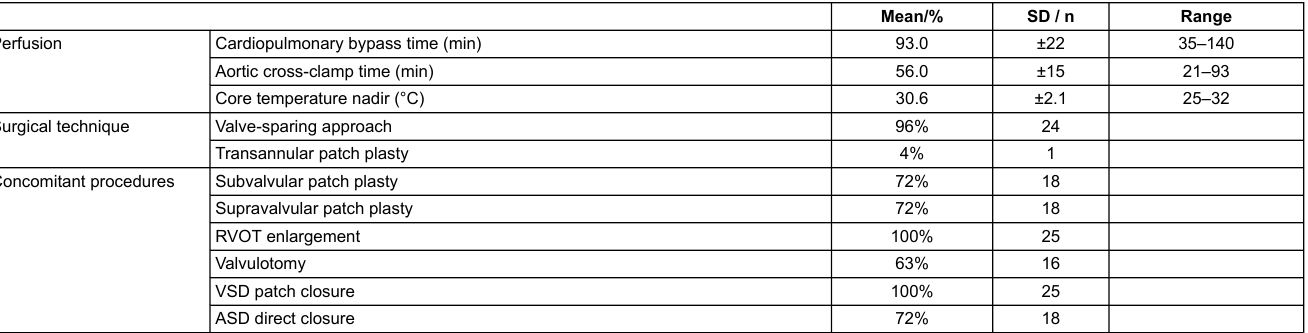
Table 2: Intraoperative data and surgical procedures.